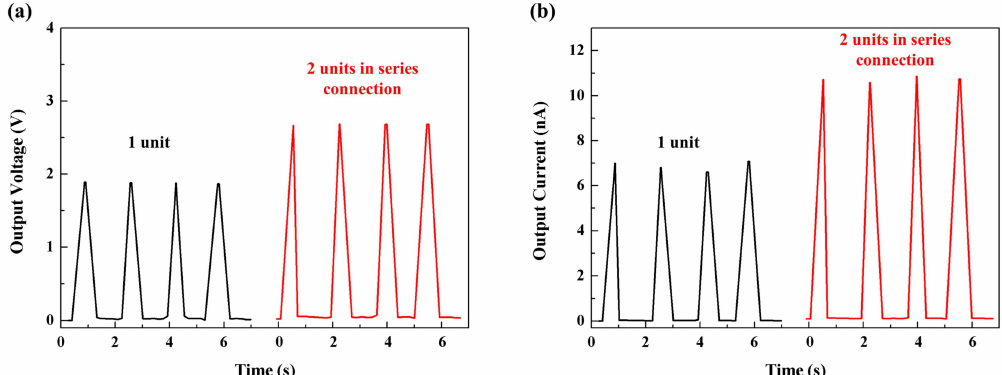
Figure 9. ( a ) Output voltage waves of the piezoelectric units with aligned electrospun PVDF/CNT under 100 ◦ bending in series connection. ( b ) Output current waves of the piezoelectric units with aligned electrospun PVDF/CNT under 100 ◦ bending in parallel